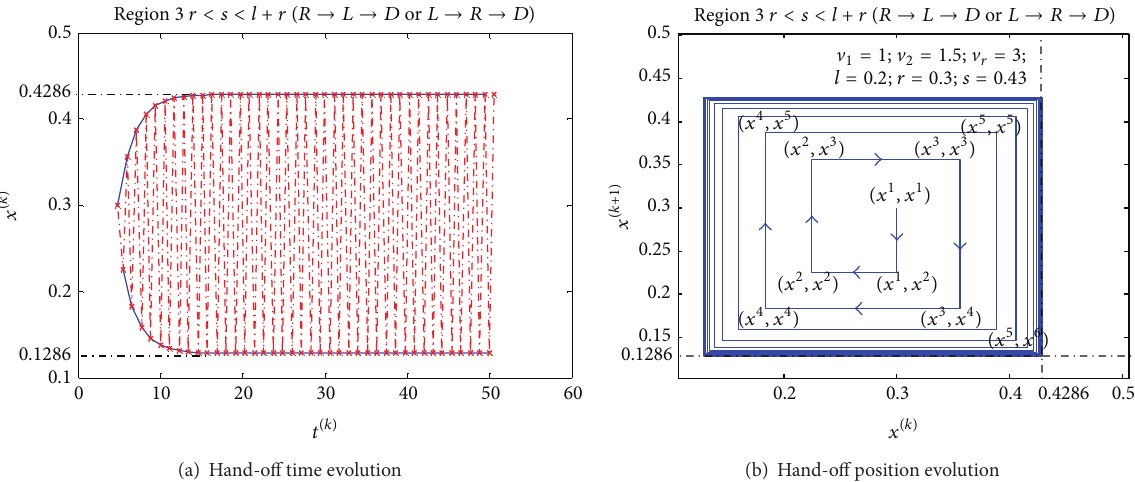
Figure 5: Convergence process in Region 3.